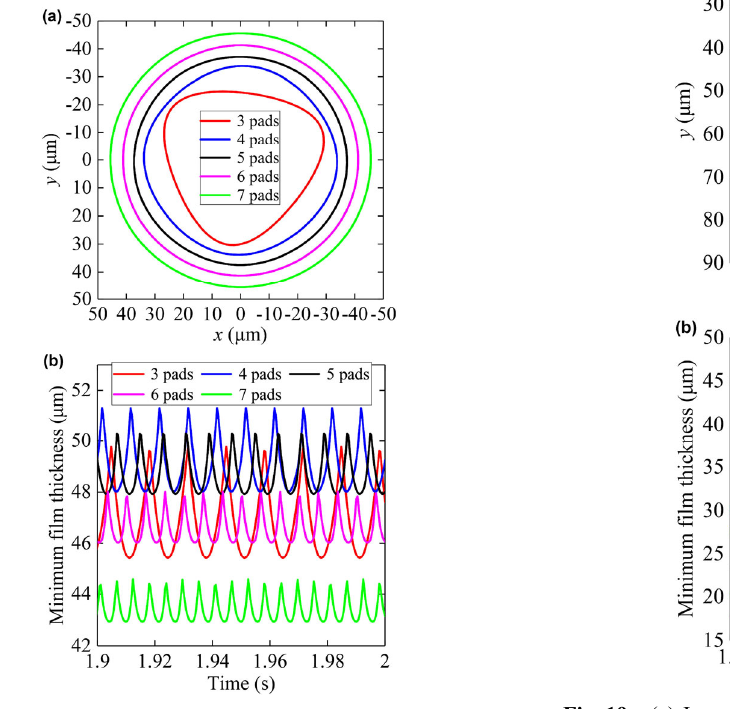
Fig. 18 (a) Journal center orbits and (b) dynamic minimum film thicknesses of a TPJB without static loads for different numbers of pads.